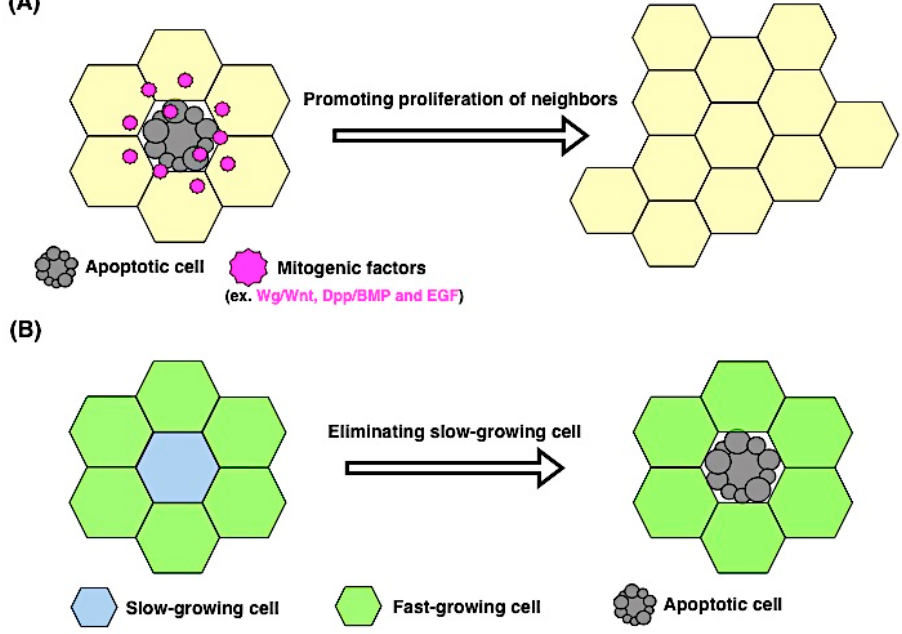
Figure 3. The control of cell numbers in tissue by non-autonomous effects of proliferation and apoptosis. ( A ) Apoptosis-induced proliferation. Apoptotic cells secrete mitogenic signals (e.g., Wnt, BMP and EGF) that induce the proliferation of neighboring cells (yellow hexagons) and contribute to tissue regeneration; ( B ) Proliferating cells induce non-autonomous apoptosis. Slow-growing cells are eliminated by their surrounding fast-growing cells. This event, called cell competition, is essential for the maintenance of tissue homeostasis.